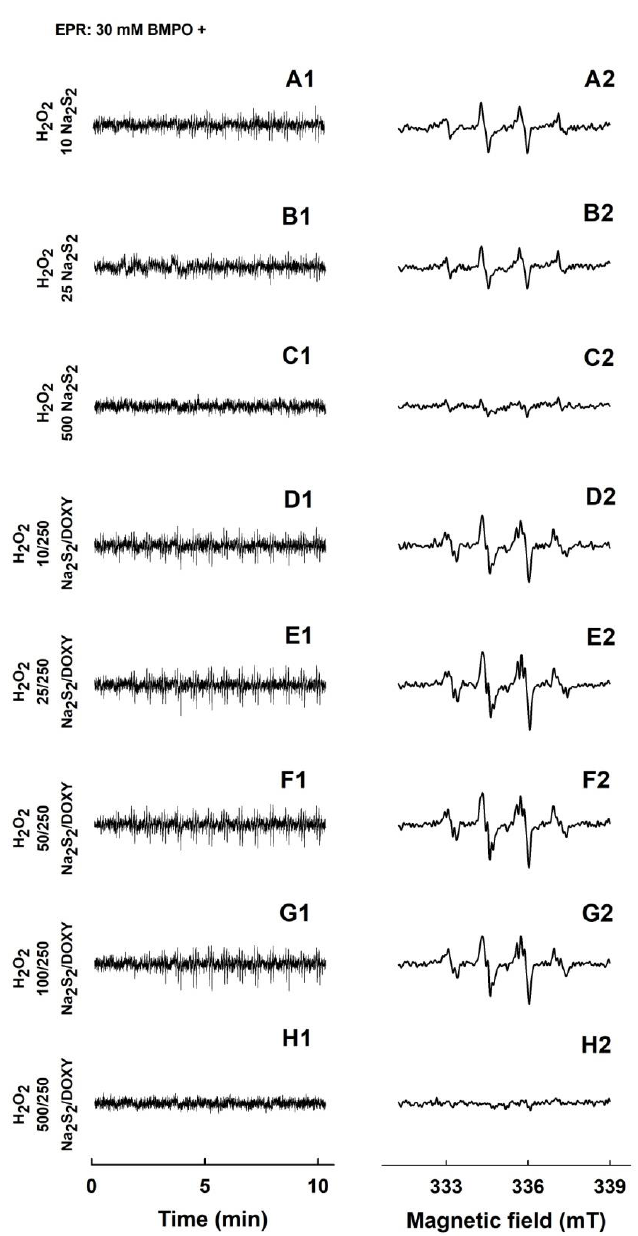
Figure 8. EPR spectra of the • BMPO-adducts for H 2 O 2 , Na 2 S 2 , DOXY and their mutual